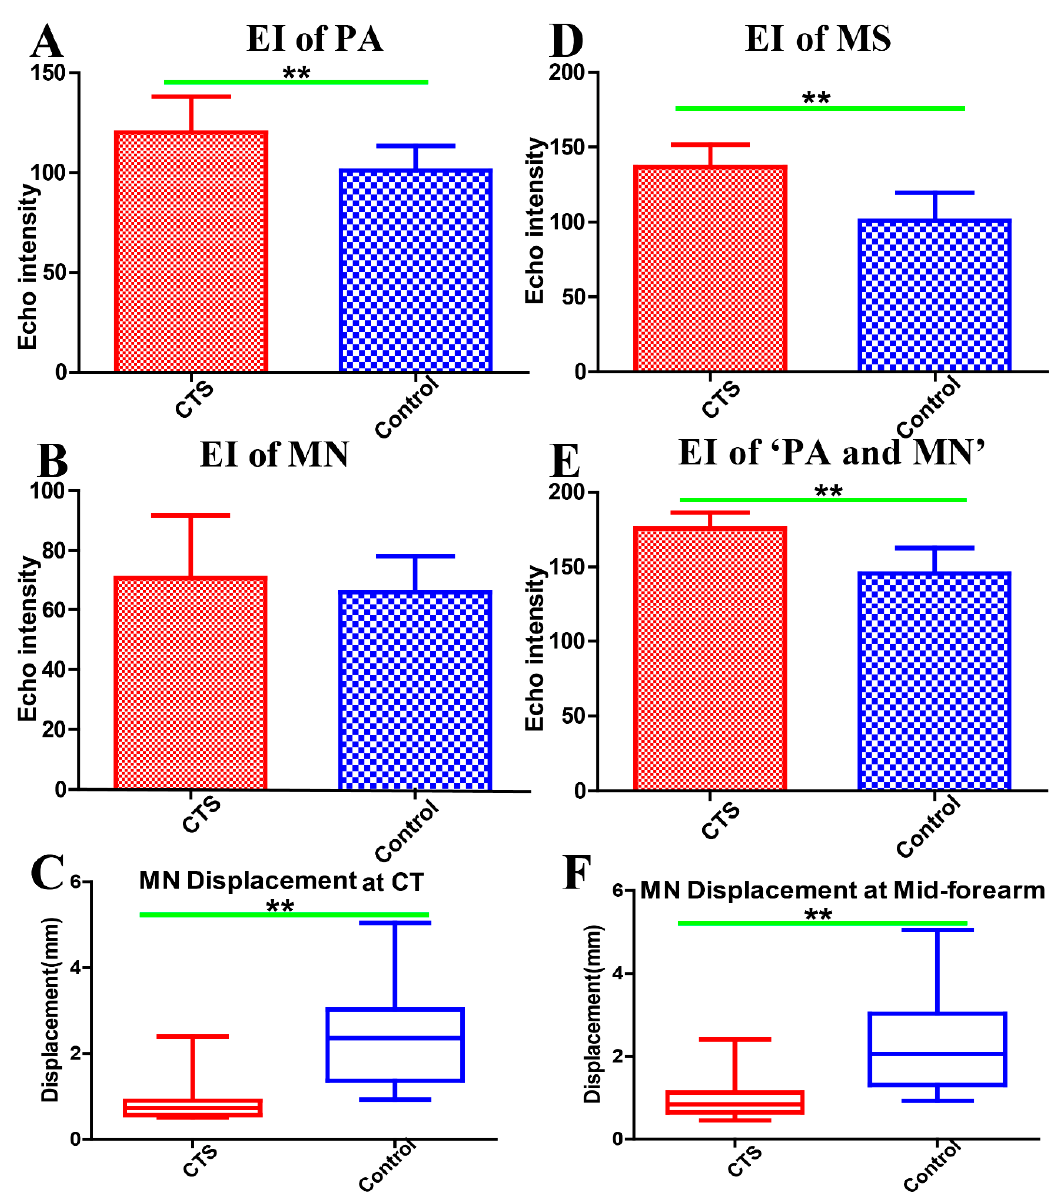
Figure 2. Echo intensity of the paraneural area at the carpal tunnel ( A ). Echo intensity of the median nerve at the carpal tunnel ( B ). Median nerve displacement at the carpal tunnel ( C ). Echo intensity of myofascial structure around the median nerve (1 cm 2 ) at the mid-forearm ( D ). Echo intensity of the paraneural area and median nerve at the mid-forearm ( E ). Median nerve displacement at the mid- forearm ( F ). EI: echo intensity, PA: paraneural area, MN: median nerve, CT: carpal tunnel, MS: myofascial structure, CTS: carpal tunnel syndrome, ** Difference between groups is statistically significant ( p < 0.01). 4. Discussion In the present study, we used computer-assisted greyscale analysis to measure the EI of PA, the MN at the carpal tunnel, the EI of the MS, and the ‘PA and MN’ at the mid-forearm. The results demonstrated excellent inter-rater and intra-rater reliability for these US parameters in the control group. This is in agreement with previous studies, which have demonstrated that computer-assisted greyscale analysis is a quantitative, reproducible and valid method of analyzing US images of skeletal muscles, and has been used to determine the EI of muscle and MN [11] and to diagnose